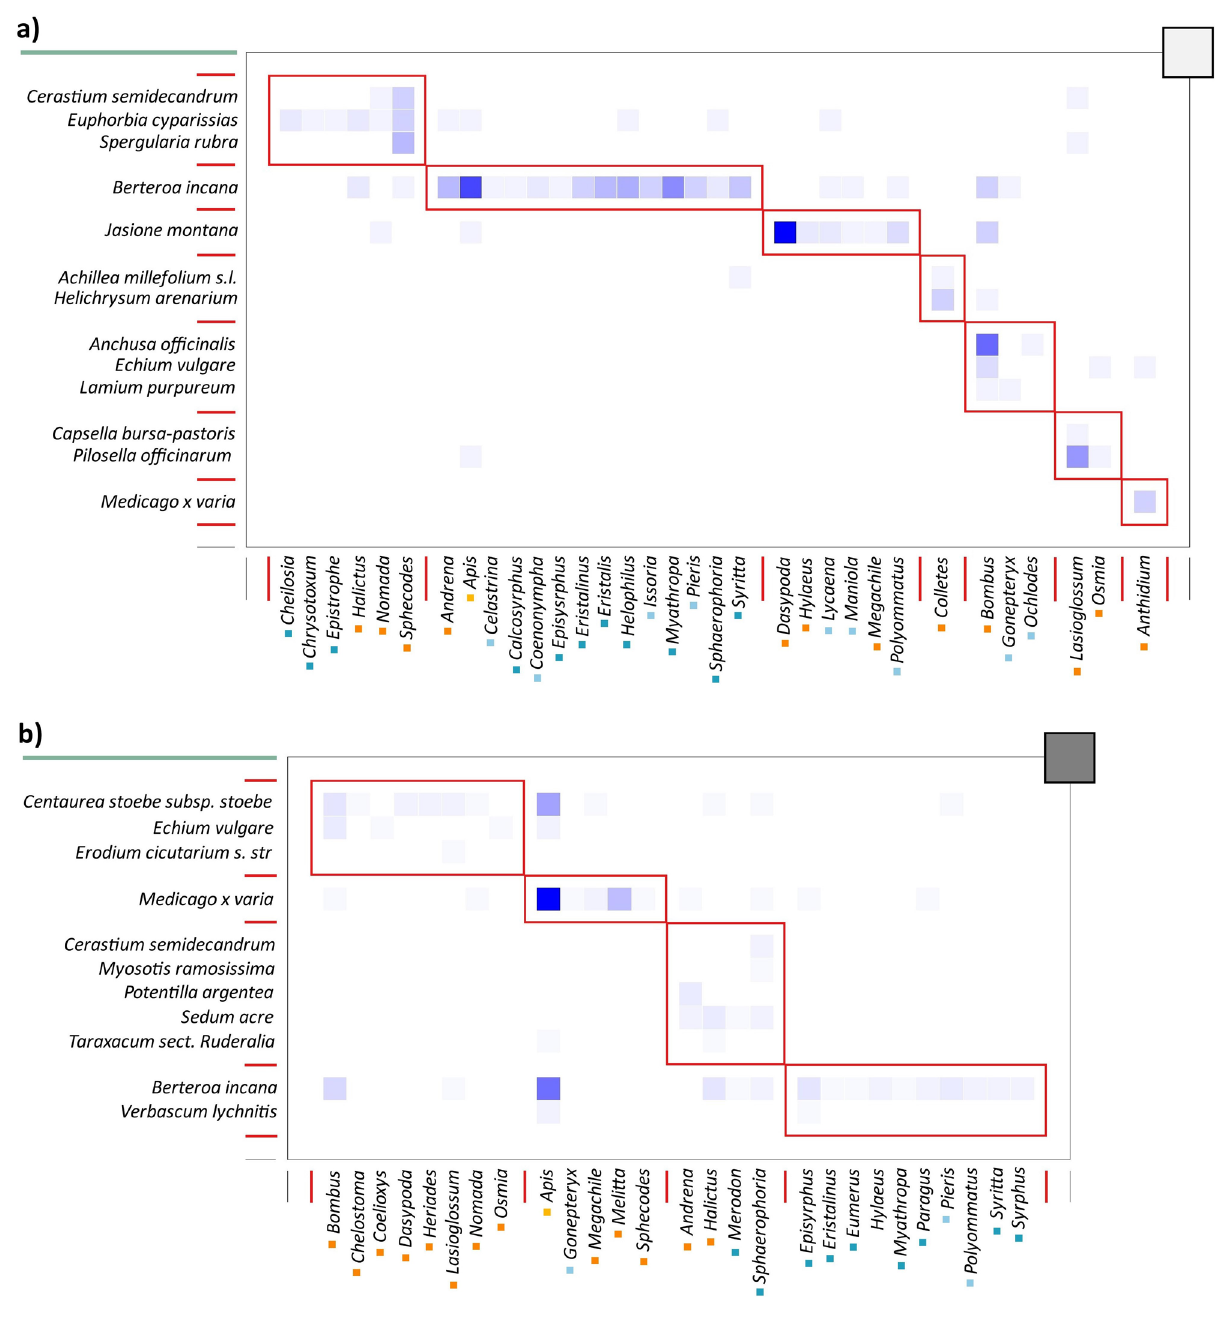
Figure 4. Comparison between two flower visitor networks (genus level) in terms of their modularity. ( a ) Modularity plot of a flower visitor network from a less urbanised site (site 1; ∆-modularity = 0.350). ( b ) Modularity plot of a flower visitor network from a highly urbanised site (site 6; ∆-modularity = 0.138). Flowering plants are resolved at the species level; pollinators at the genus level. Plants and pollinators are sorted by modular affinity, plant species as rows and pollinator genera as columns. The darker squares represent more frequent interactions. The red boxes separate the modules and the cells inside the boxes are the interactions within the modules. Wild bee genera are labelled orange, hoverfly genera dark blue, butterfly genera light blue and honey bees urbanisation, but total pollinator activity increased at sites with high vegetation height. Although we did not find an effect of impervious surfaces on hoverfly diversity, wild bees and butterflies were negatively affected by the degree of urbanisation. Furthermore, local flowering plant richness and bare soil cover had a positive effect on the diversity of wild bees and the height of vegetation had a positive effect on the visitation rates of butterflies and hoverflies. The community composition of pollinator species was influenced by the degree of urbanisation, bare soil cover and 3D connectivity. The degree of urbanisation had a positive effect on the abundance of flowering